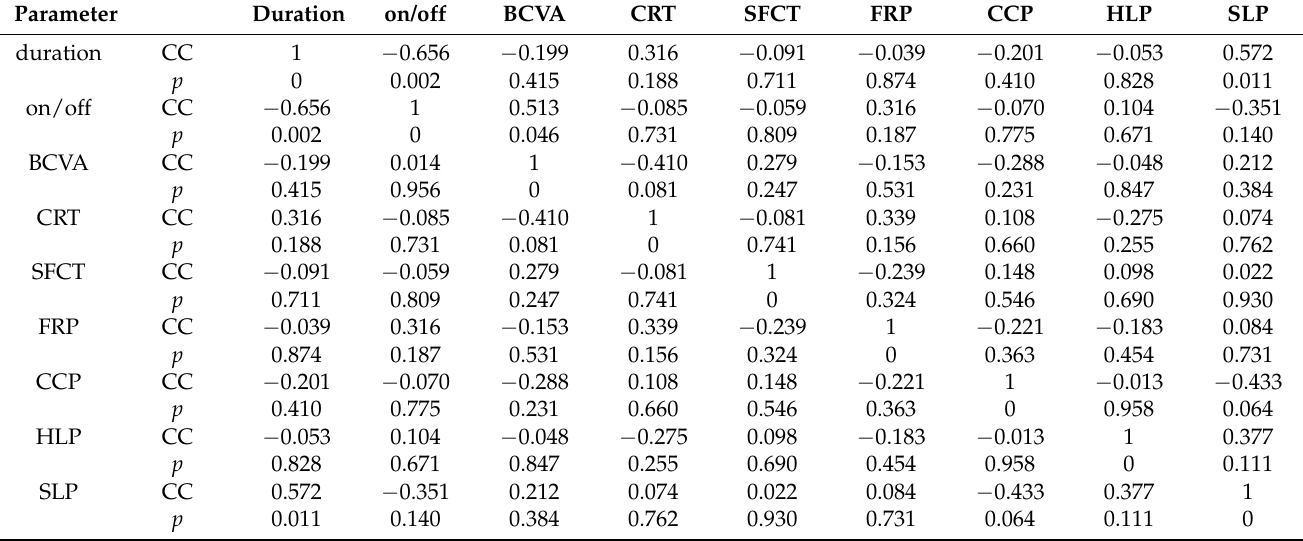
Table 3. Correlation analysis of functional and morphological data at baseline.